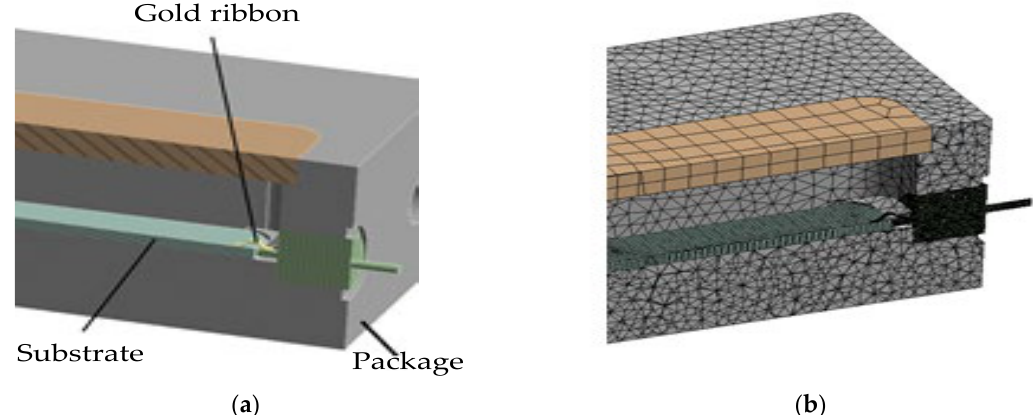
Figure 16. Analysis model of the novel horizontal interconnection. ( a ) The stress analysis model; ( b ) Meshes of the model.